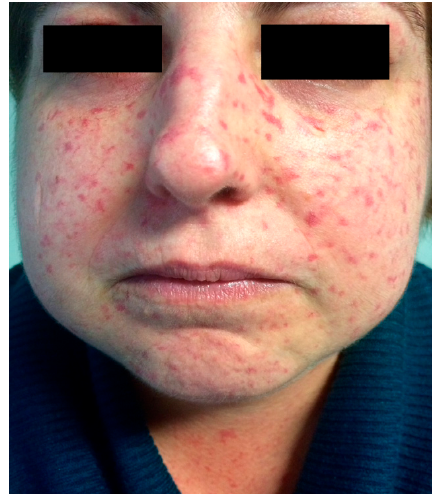
Figure 1. Presence of telangiectasia.